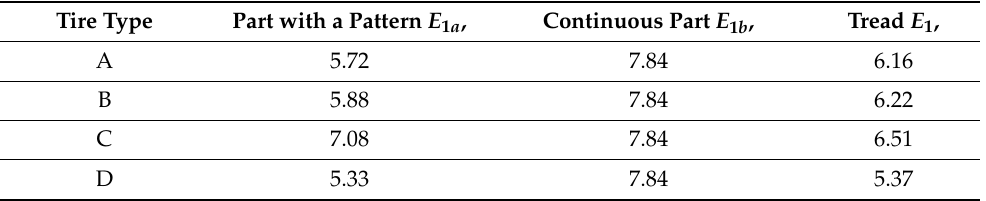
Table 3. Tread modulus of elasticity obtained by assessment using the first model, MPa. Tire Type Part with a Pattern E 1 a , Continuous Part E 1 b